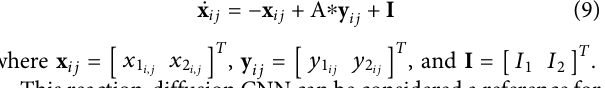
Frontiers in Physics |